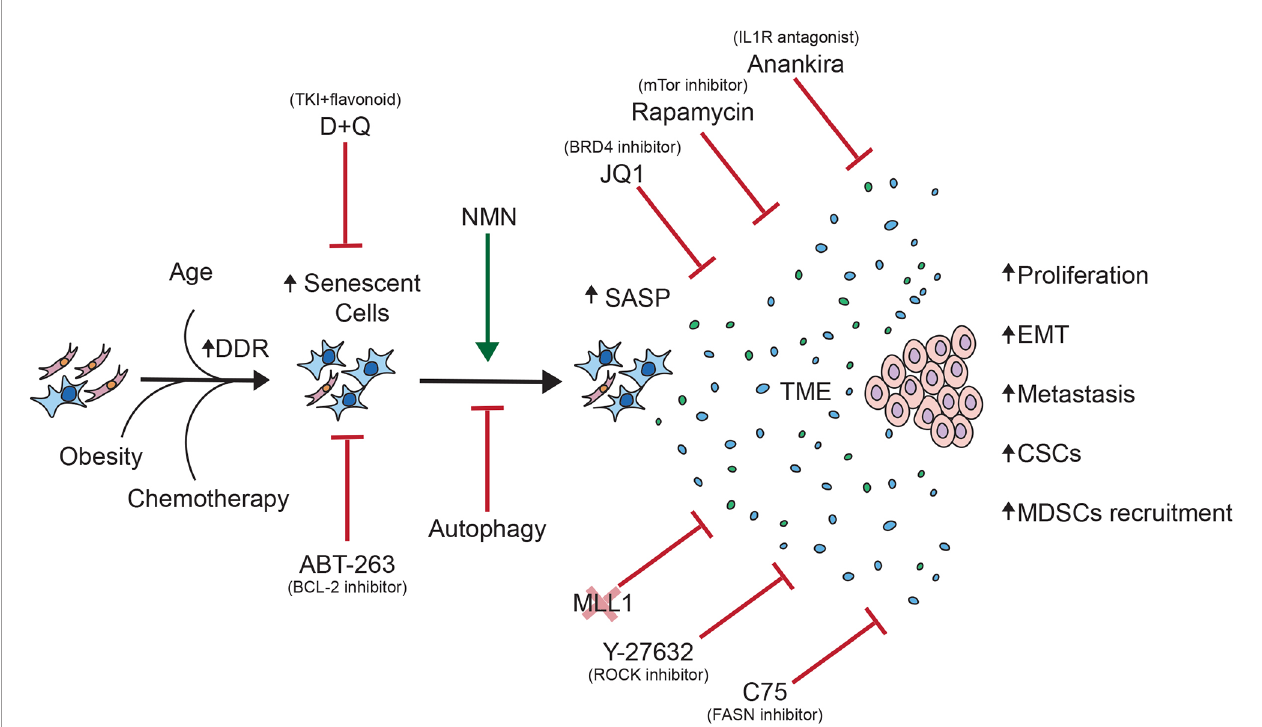
FIGURE 2 | Overview of the contribution of senescent cells to cancer progression. This schematic summarizes the pro-tumorigenic effects of the SASP on tumor cells as well as therapeutic opportunities to abrogate said